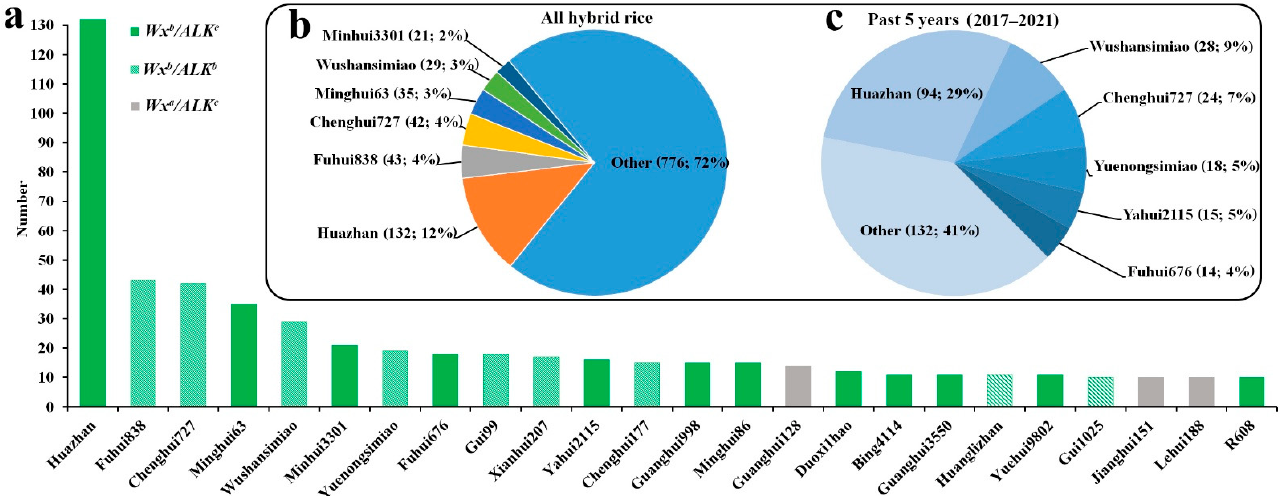
Figure 5. Hybrid rice varieties bred using RLs. ( a ) RLs of male plants used to breed > 10 hybrid rice varieties. ( b ) All hybrid varieties cultivated using the restorer line in this experiment. ( c ) Hybrid varieties cultivated in the past 5 years using the restorer line in this experiment.